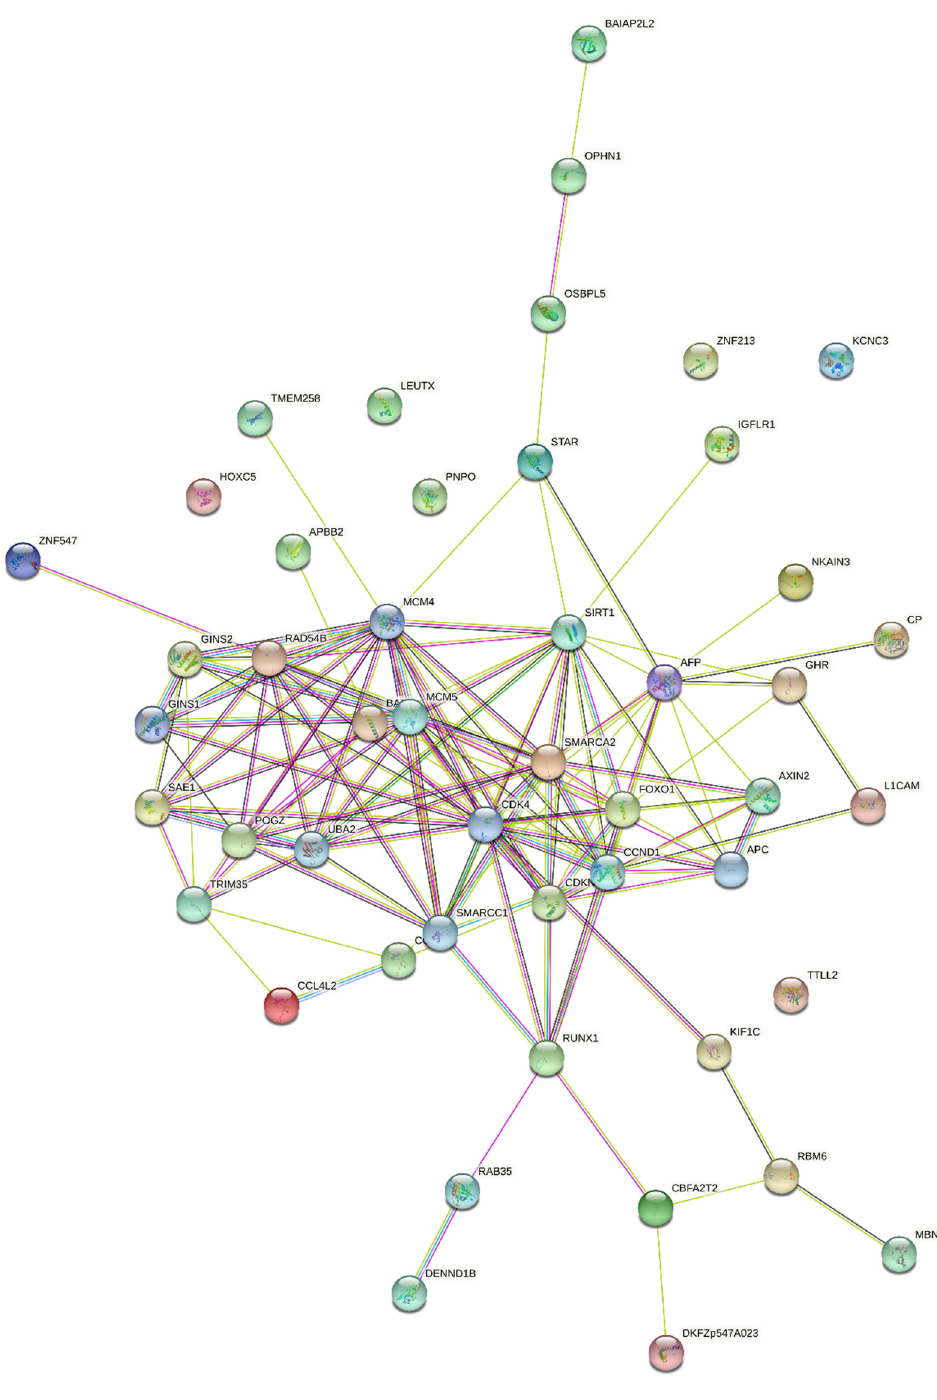
Figure 5. Protein–protein interaction networks constructed by STRING resource for genes encoding ( A ) AFP 14–20 -like motif-containing proteins and ( B ) GIP-9-like motif-containing proteins. ENSEMBL gene IDs or STRING-db protein IDs were used. Colored nodes—query proteins and first shell of interactions; white nodes—second shell of interactions; filled nodes—proteins of known or predicted 3D structure; empty nodes—proteins of unknown 3D structure. Known interactions: blue—from curated databases and violet (experimentally determined). Predicted interactions: red—gene fusions; green—gene neighborhood; purple—gene co ‐ occurrence. Other interactions: lilac—protein homology; black—gene coexpression; light green—text mining.